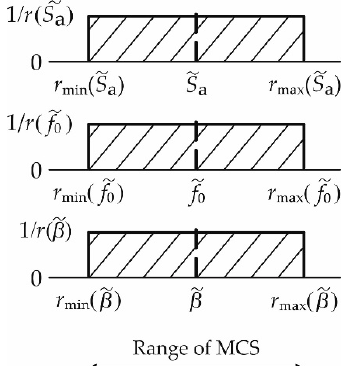
Figure 4. Range of the Monte Carlo procedure (MCP) for the estimates associated with the accelerometer model.